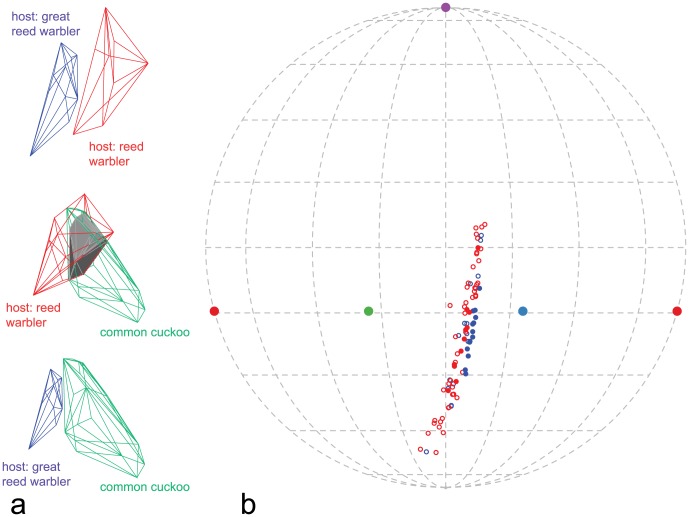
Cuckoo and host eggs in tetrahedral bird average visual colour space.(a) Overlap of convex hulls (grey polyhedron) encapsulating point measurements of host (red and blue) and cuckoo (green) eggs. Second and third plot are presented in identical orientations for ease of comparison and rotated to maximize the visibility of differences on the third plot (i.e. where there is no overlap). (b) Projection of colour measurement on a circumscribed sphere of the colour space tetrahedron; open symbols – cuckoos, filled symbols – hosts, red – reed warbler nests, blue – great reed warbler nests.